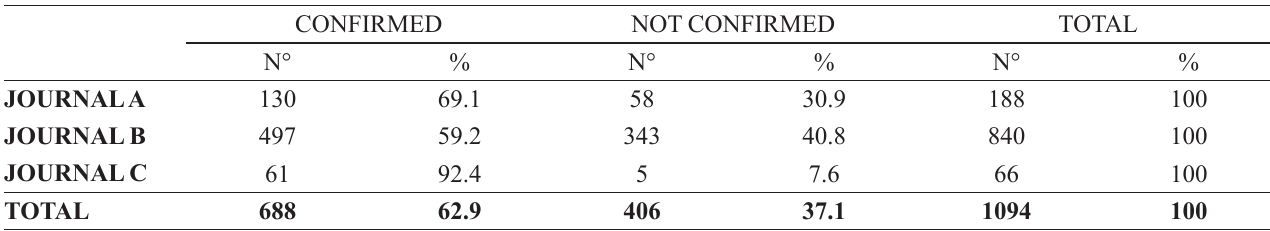
TABLE IV – Evaluation of quotations per type of journal CONFIRMED NOT